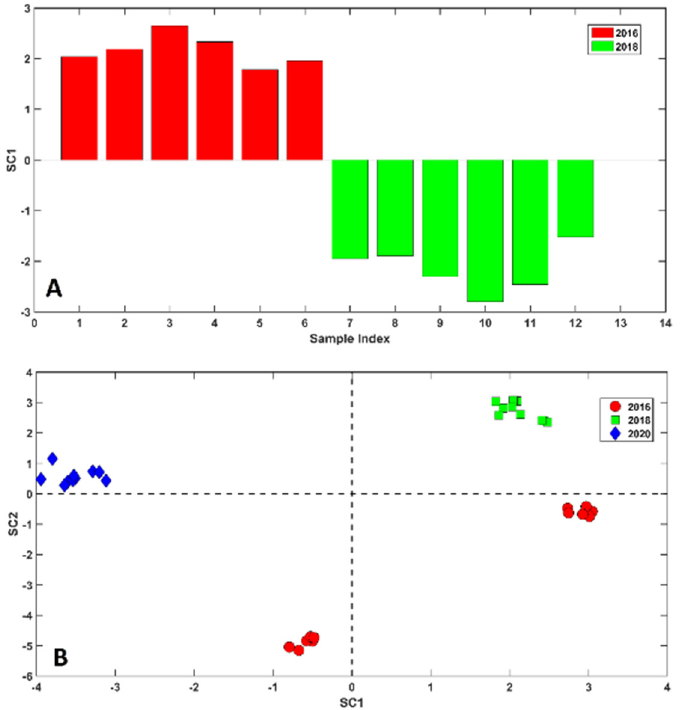
Figure 2. ASCA model of the year effect . ( A ) SC values associated with the Spoleto objects. Legend: red bars: saffron harvested in 2016; green bars: saffron harvested in 2018. ( B ) Samples from Città della Pieve projected onto the space defined by the first two SCs. Legend: red dots—2016; green squares—2018; blue diamonds—2020.